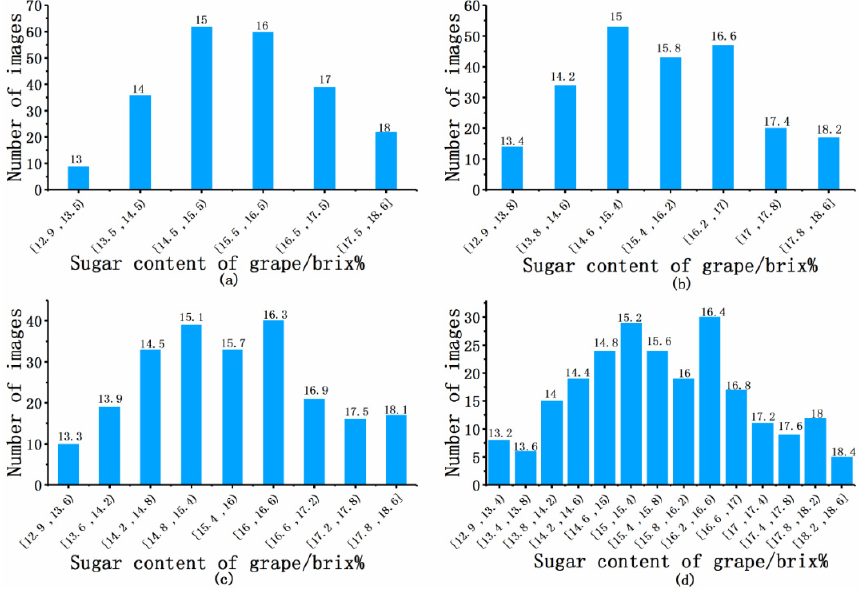
Figure 3. Imbalanced grape datasets. Datasets divided into intervals of ( a ) 1%, ( b ) 0.8%, ( c ) 0.6%, and ( d ) 0.4%. The value at the top of each bar is the average label for that category.